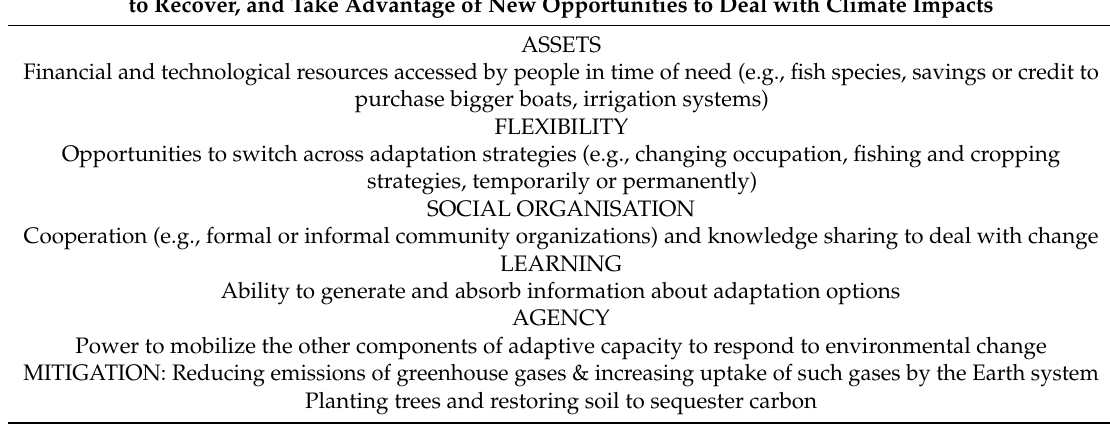
Table 2. Analytical framework for adaptation, mitigation and development co-benefits and challenges of case studies: definitions and